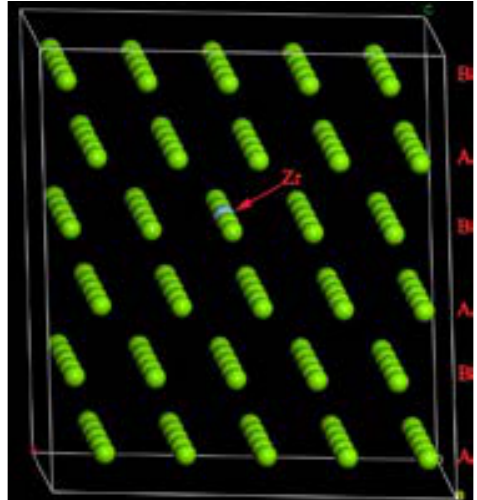
Figure 1. The crystal structure of the calculation